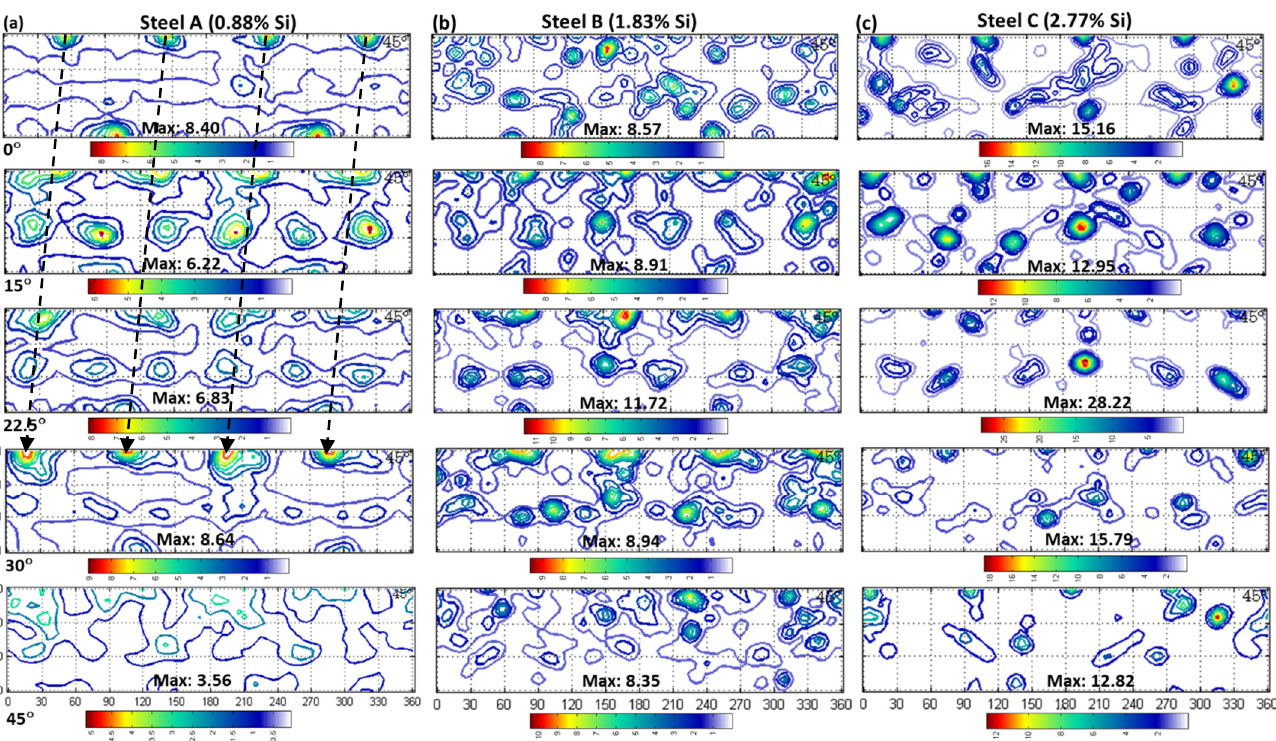
Figure 8. Textures of the skew-cold-rolled steels (unidirectional feeding) after annealing: ( a ) Steel A, ( b ) Steel B and ( c ) Steel C. ϕ 2 = 45° sections of the Euler space (Bunge notation).